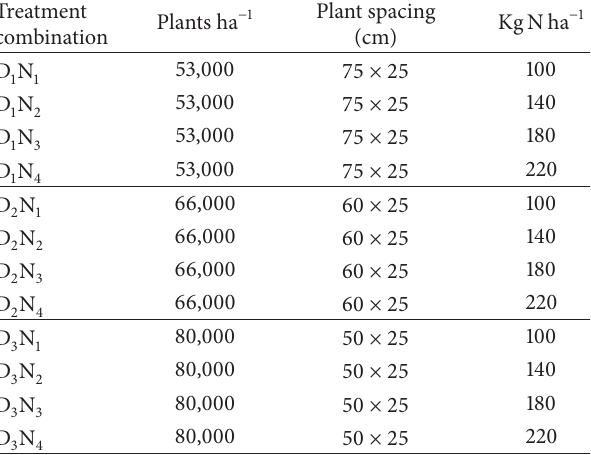
Table 1: The treatment combinations used in this